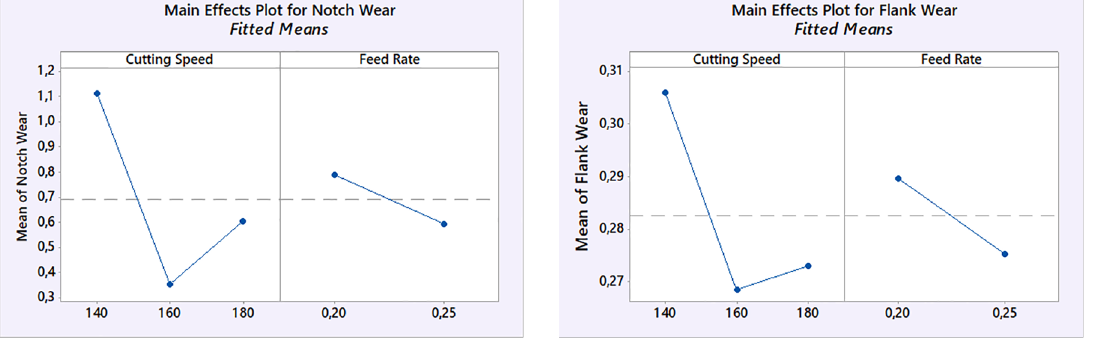
Figure 4. Notch wear in function of cutting speed and feed-rate Figure 6. Flank wear in function of cutting speed and The greatest notch wear (VB ) was observed at the N